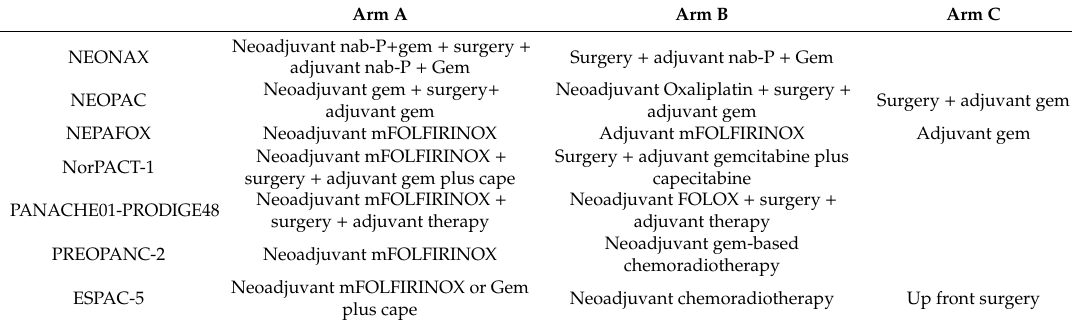
Table 4. Ongoing